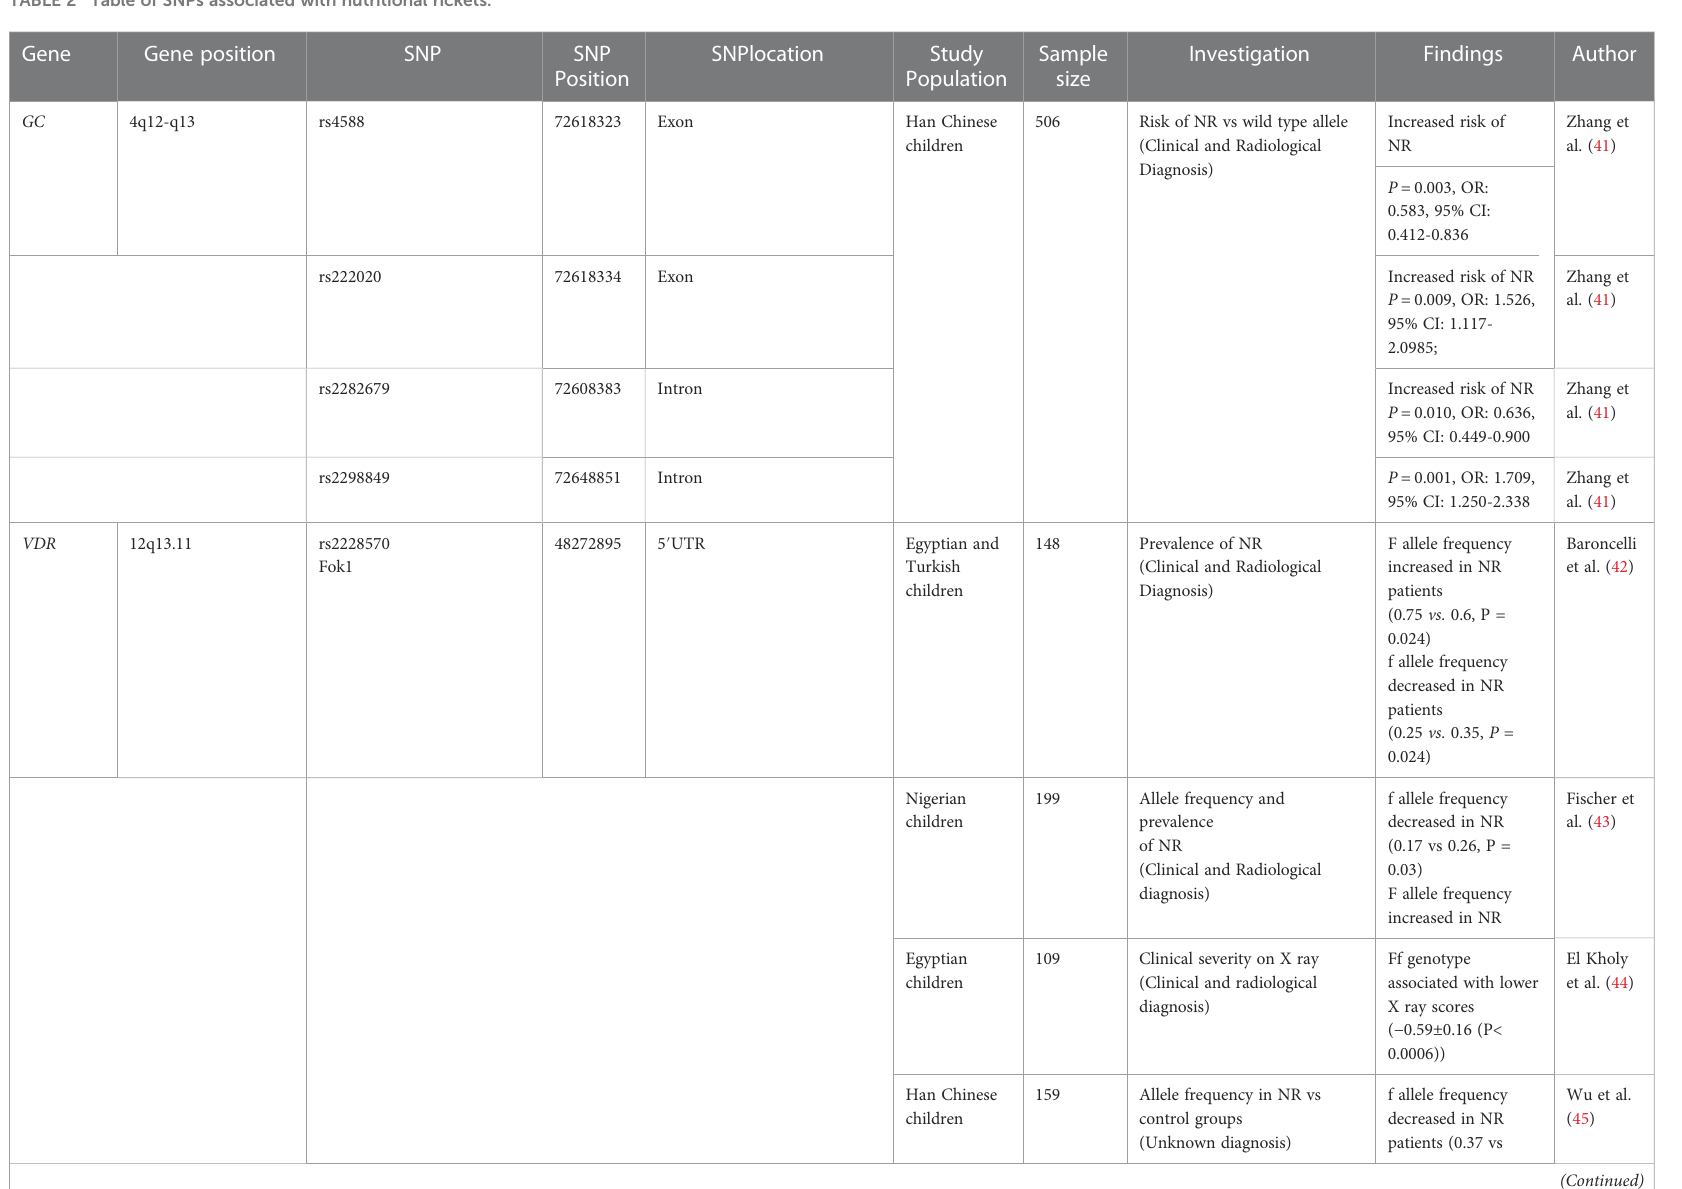
TABLE 2 Table of SNPs associated with nutritional